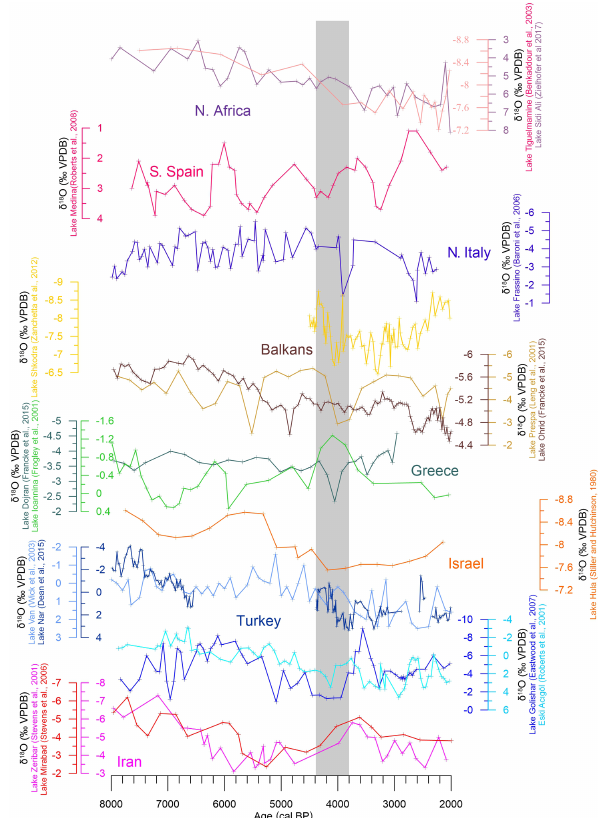
Figure 3. Selected lacustrine δ 18 O records. For location, refer to Fig. 1 and for references to Table